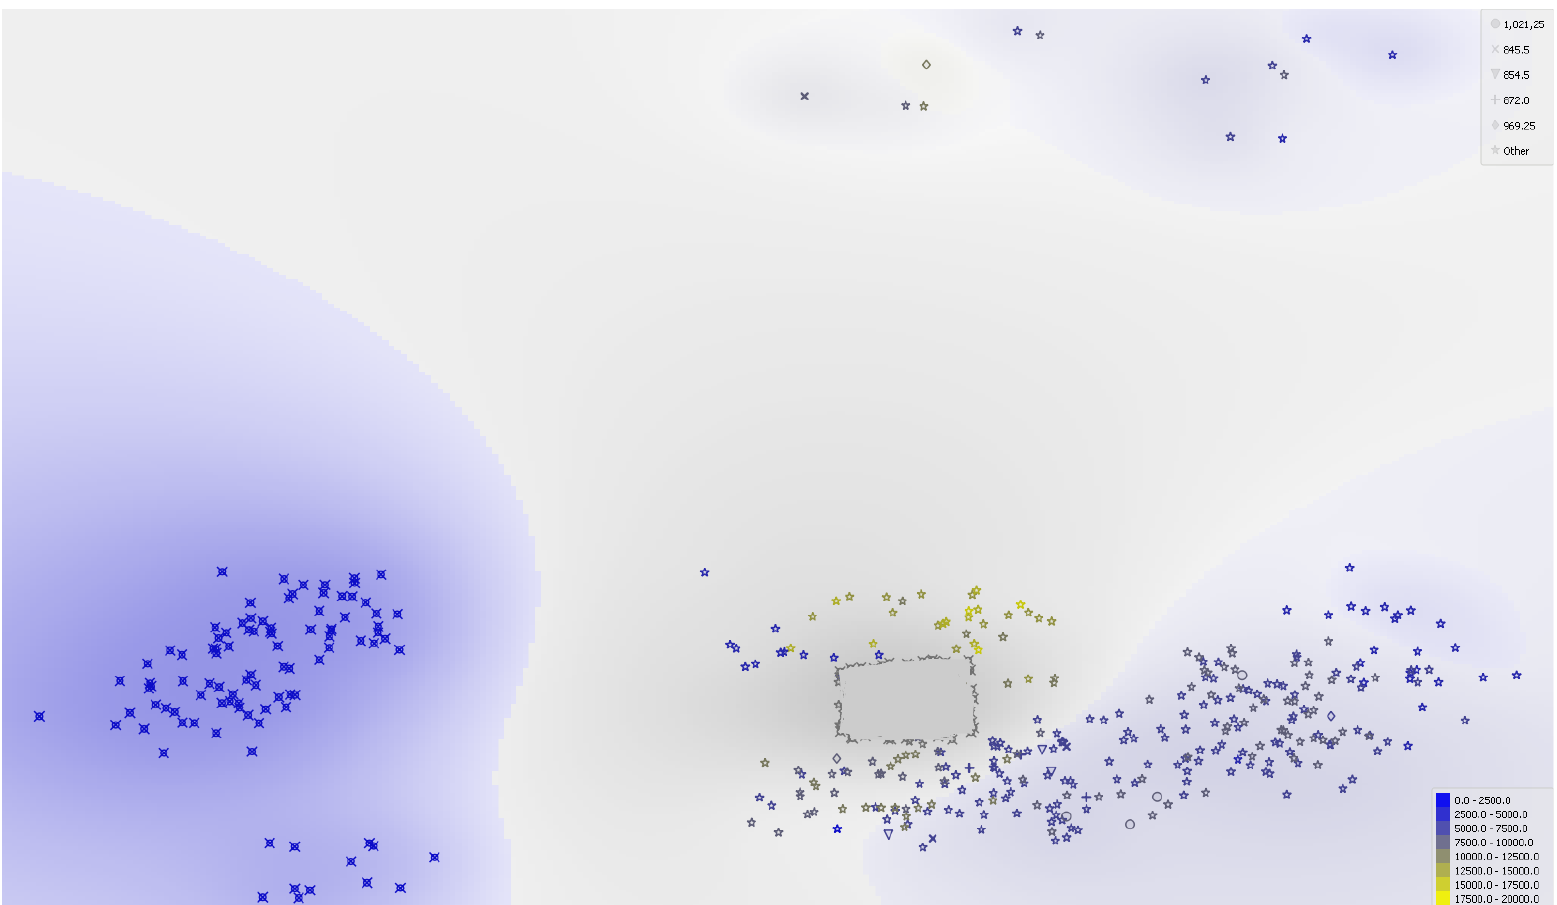
Figure 7. Multi-Dimensional Scaling map concerning Bitcoin spot. Note: multi-dimensional scaling is a technique that finds a low-dimensional (e.g., two-) projection of points, where it tries to fit distances between points as well as possible. The algorithm iteratively moves the points around in a kind of a simulation of a physical model. If two points are too close to each other (or too far away), there is a force pushing them apart (or together). The change of the point’s position at each time interval corresponds to the sum of forces acting on